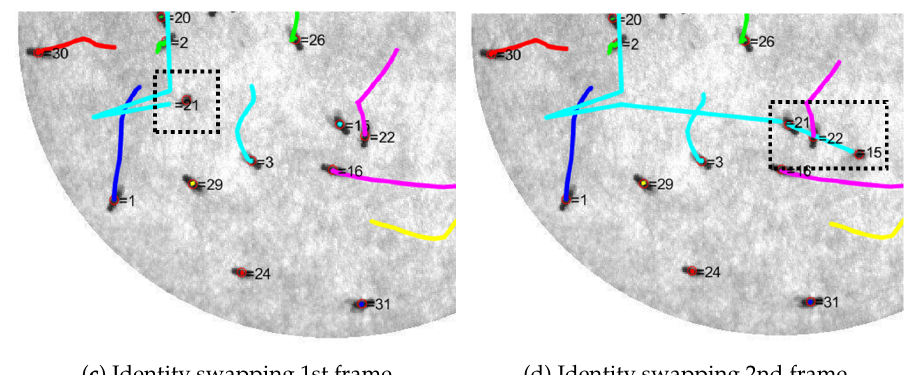
Figure 16. Examples of identity loss and identity swapping scenes from two different videos. Identity loss occurred at fly number 4 in ( a ) and it was lost in ( b ). The new tracker number 33 was assigned to the fly instead. Identity swapping is shown in ( c ) and ( d ). Fly number 21 was flying ( c ) and passed fly number 15 in the next frame. Their identities swapped as seen in ( d